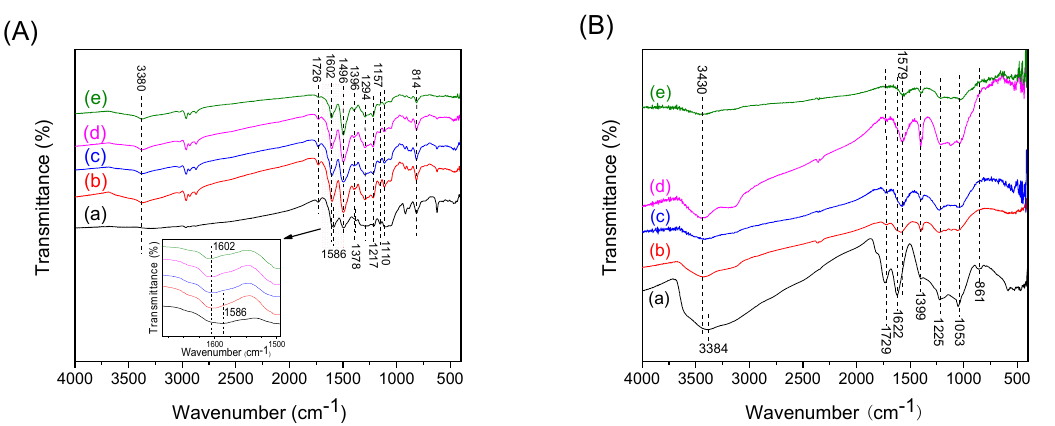
Figure 2. ( A ) FT-IR spectra of as-synthesized PEANI / GO (a) and PEANI / rGO obtained by reduction with hydrazine of 70 µ L (b), 140 µ L (c), 420 µ L (d), and 1400 µ L (e). ( B ) FT-IR spectra of GO (a) and rGO obtained after reduction with hydrazine of 25 µ L (b), 50 µ L (c), 150 µ L (d), and 400 µ L (e).